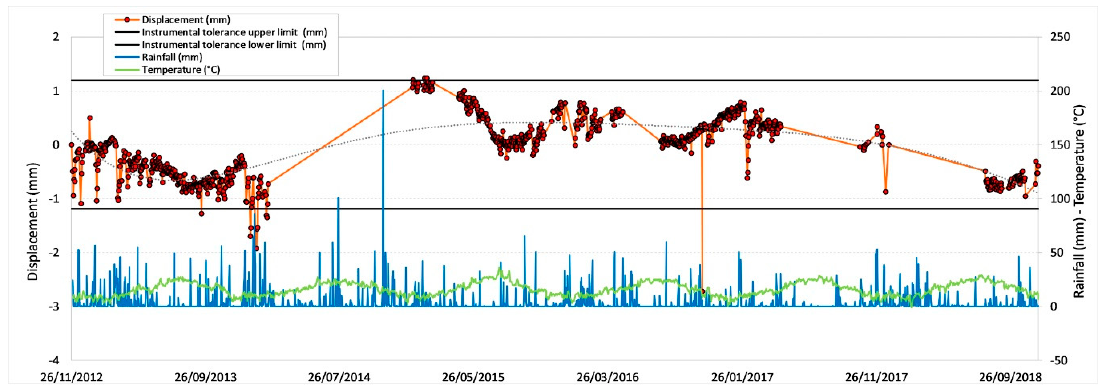
Figure 12. Displacement recorded by the RTS at the measurement point G15.